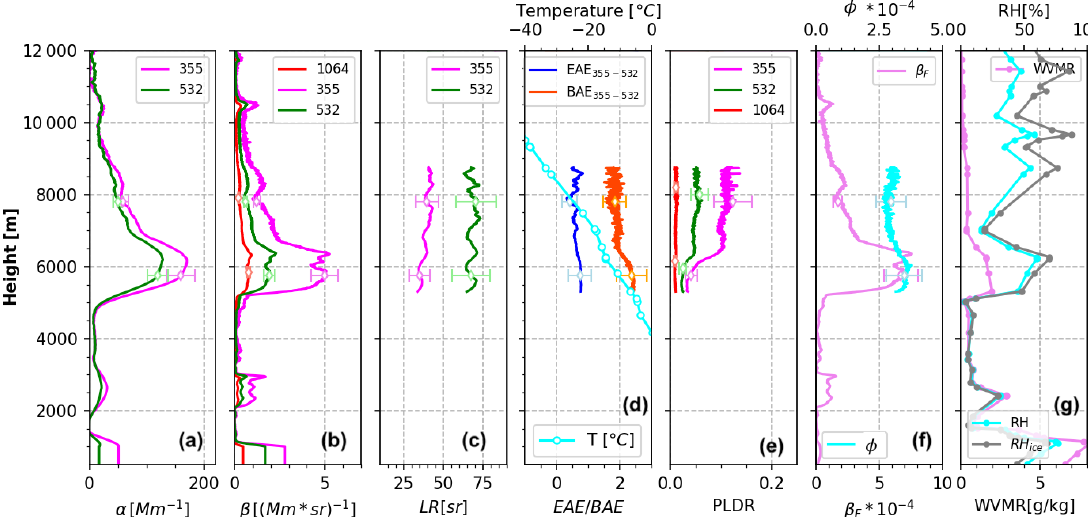
Figure 8. Aerosol vertical profiles from averaged measurements between 22:00UTC, 11 September 2020, and 03:00UTC, 12 September 2020. (a) Extinction coefficients, (b) backscattering coefficient and (c) lidar ratios. The colors of lines represent different wavelengths: 355 (magenta), 532 (green) and 1064 (red)nm. (d) EAE 355–532 (orange), BAE 355–532 (blue) and temperature (cyan open circles), (e) PLDRs, (f) fluorescence backscattering coefficient (pink) and fluorescence capacity (cyan), (g) WVMR (solid pink circles), RH to liquid water (RH, solid cyan circles) and ice (RH ice , solid gray circles). The extinction and backscatter coefficients at 355 and 532nm were calculated using the Raman technique (Ansmann et al., 1992) and the backscatter coefficient at 1064nm was calculated by the Klett method with an assumption of LR = 50sr. The radio sounding station is in Beauvechain, Belgium, about 100km from the lidar observation site. The error bars in the figure represent the statistical errors. The method of error estimation is presented in the Appendix of Hu et al. (2019). The relative humidity to ice is calculated using the improved Magnus formula in Alduchov and Eskridge